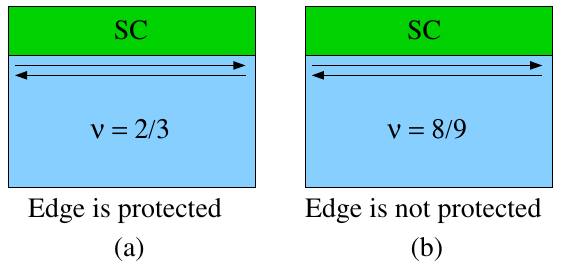
FIG. 1. To demonstrate the subtleties of protected edge modes without symmetry, we consider the (cid:4) ¼ 2 = 3 and (cid:4) ¼ 8 = 9 frac- tional quantum Hall edges, proximity coupled to an adjacent superconductor. (a) In the (cid:4) ¼ 2 = 3 case, the edge has vanishing thermal Hall conductance, K H ¼ 0 , since it contains two modes moving in opposite directions. Even so, wewill show that the edge is protected .(b)Inthe (cid:4) ¼ 8 = 9 case,theedgealsohas K H ¼ 0 ,but in this case we will show that the edge is not protected . We argue that the two states behave differently because of the different quasiparticle braiding statistics in the